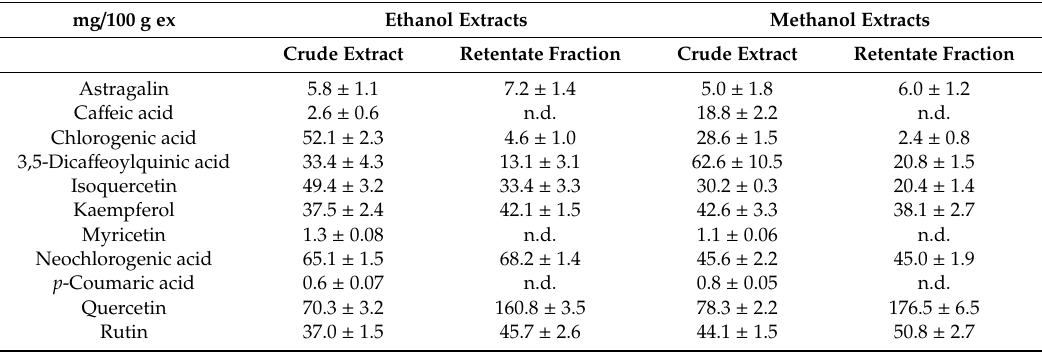
Table 3. HPLC profile of selected phenolic acids and flavonoids of S. nigra leaf extracts. mg / 100 g